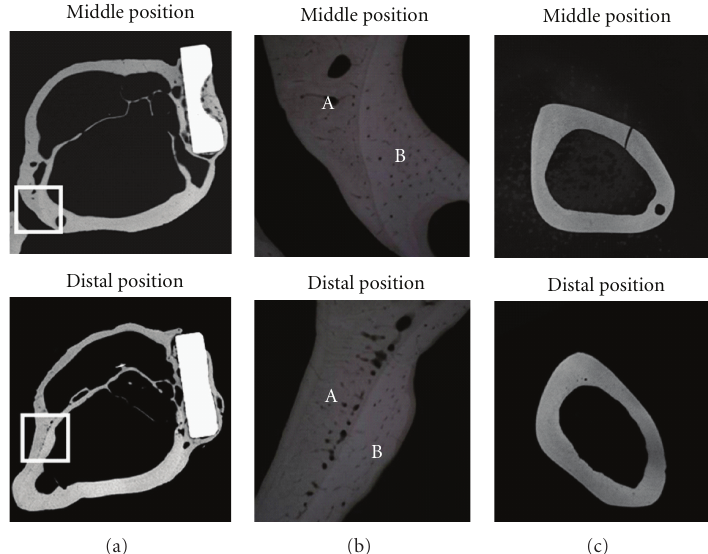
Figure 18: CMRs of cross-sections of fracture models implanted with and without bone plates made of TNTZ at middle position and distal position at 48 weeks after implantation: (a) cross-section of fracture model, (b) parts of (cid:2) of (a), namely, high magnification CMR of branched parts of bones formed outer and inner sides of tibiae, and (c) cross sections of unimplanted tibiae.